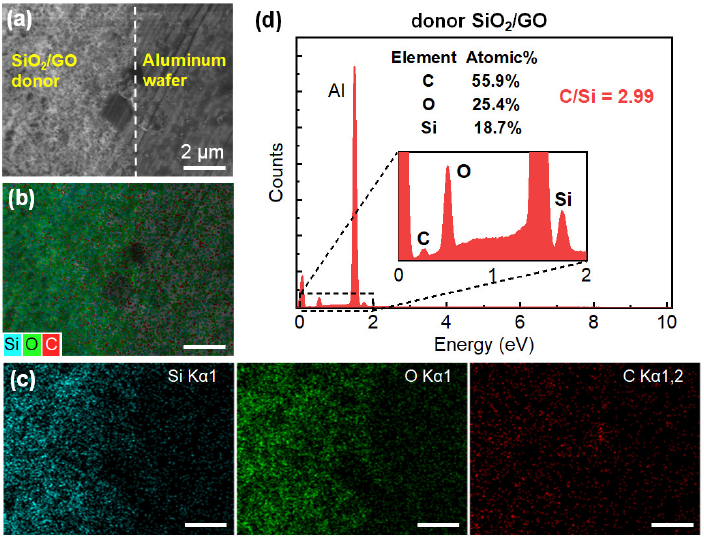
Figure 5. ( a ) SEM image, ( b , c ) elemental mapping analysis, and ( d ) EDX analysis of the donor film. The white dash line roughly indicates the boundary between the donor film and bare Al wafer. The scale bars in figures ( b , c ) indicate 2 μm.